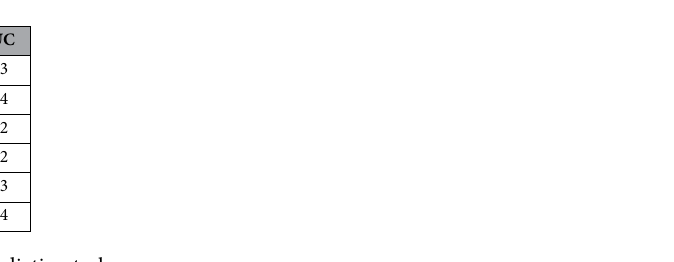
Table 2. Results on suicide risk prediction